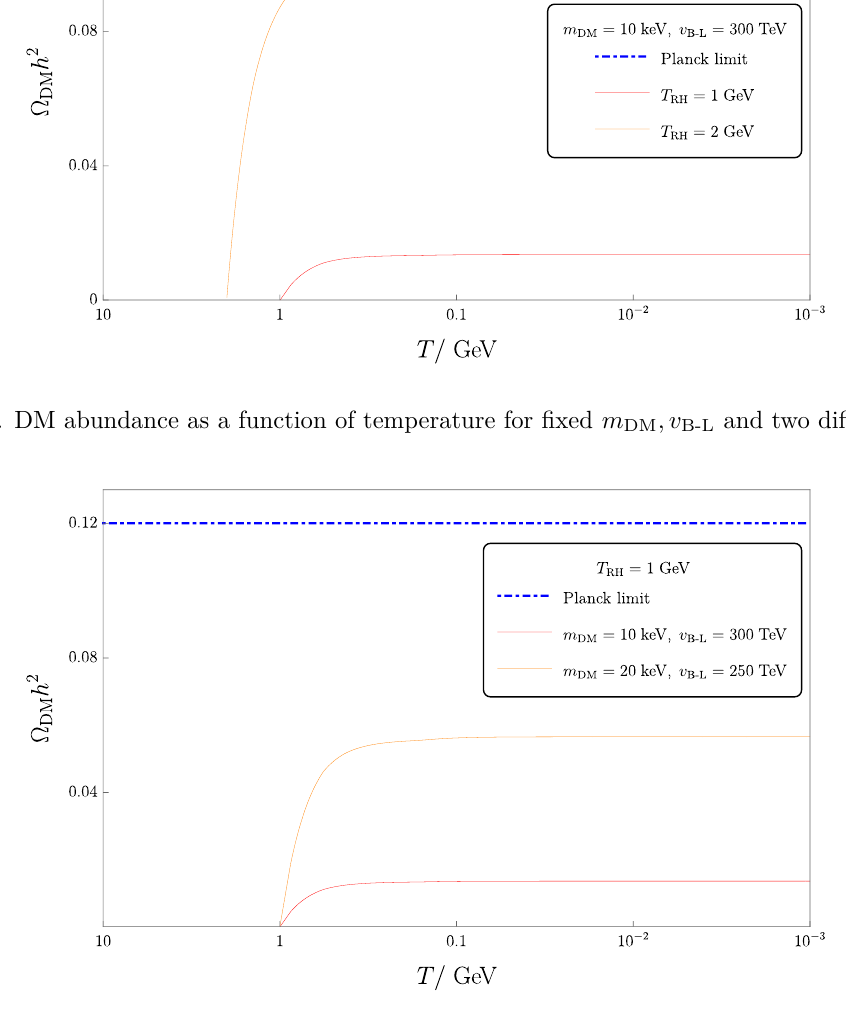
Figure 4 . DM abundance as a function of temperature for fixed T RH and two different combinations of m DM , v B-L